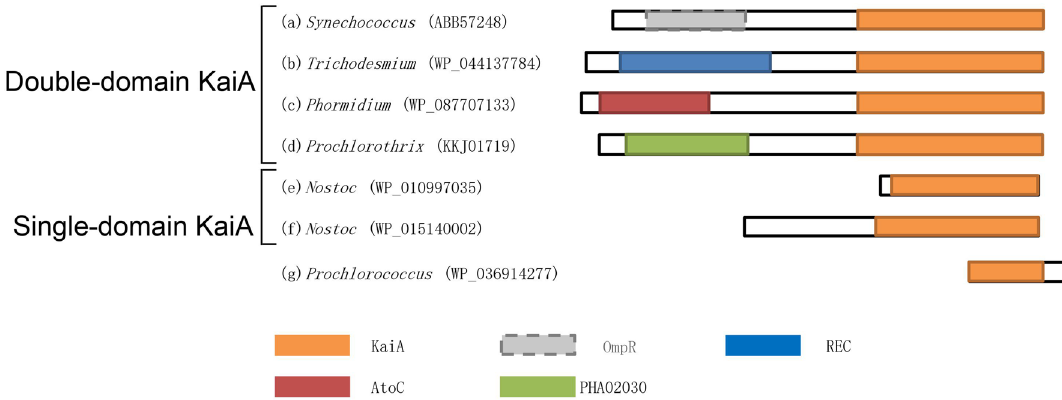
Figure 1. The domain architecture of KaiA proteins. ( a ) Synechococcus (ABB57248); ( b ) Trichodesmium (WP_044137784); ( c ) Phormidium (WP_087707133); ( d ) Prochlorothrix (KKJ01719); ( e ) Nostoc (WP_015140002); ( f ) Nostoc (WP_010997035); ( g ) Prochlorococcus (WP_036914277). Homology to the OmpR domain is weak and denoted by dashed